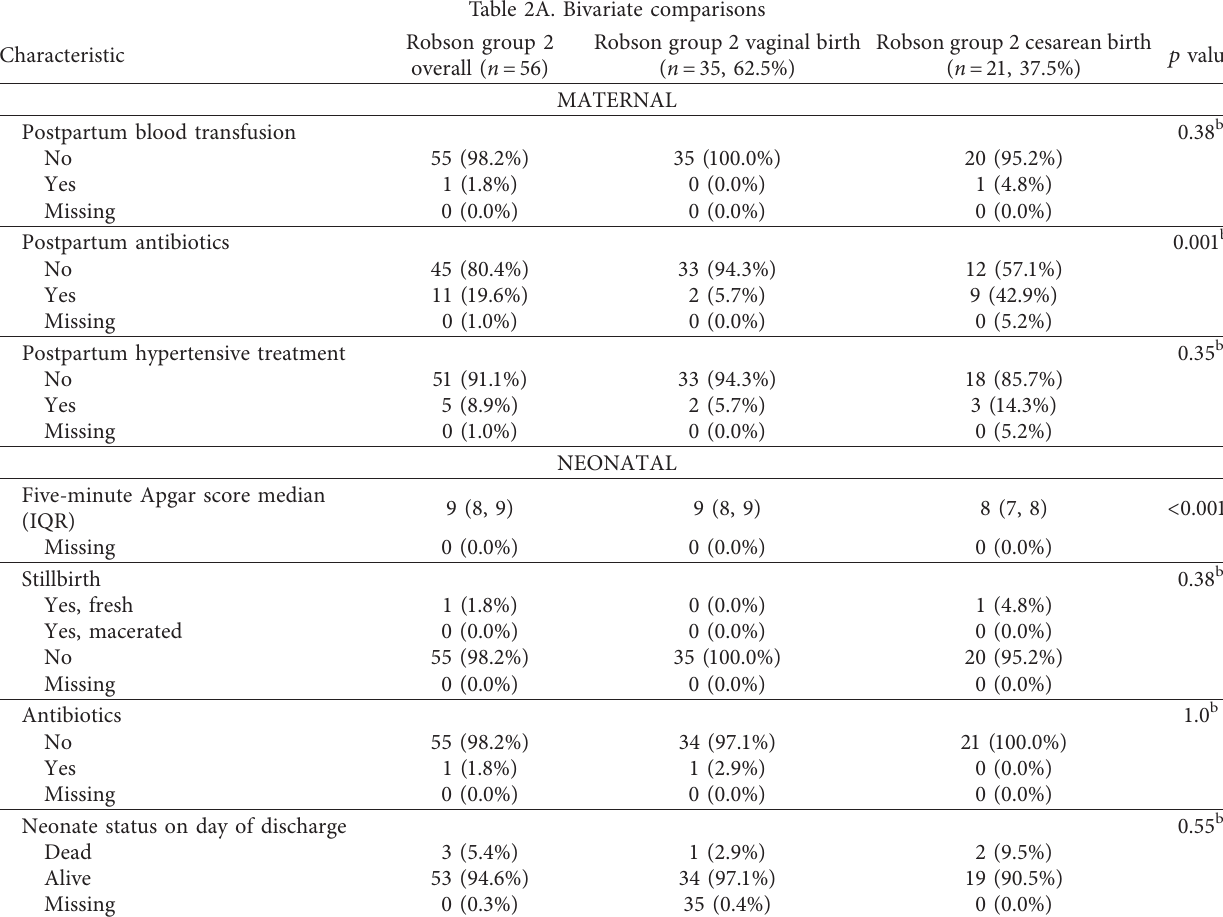
Table 2A. Bivariate comparisons